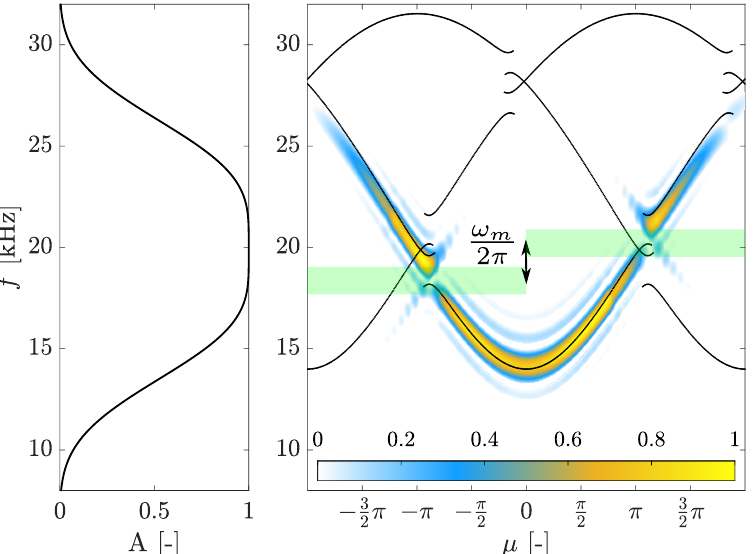
Figure 6. Numerical dispersion, obtained with the COMSOL Multiphysics model, vs. analytical prediction (black line), obtained with the spring-mass chain model and the BBP ( right ) and spectrum of the input tone burst ( left